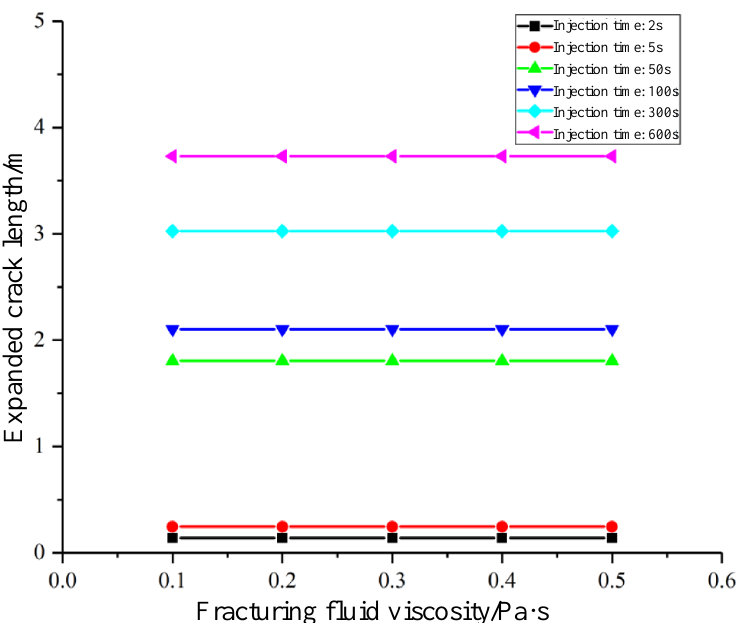
Figure 21. The e ff ect of fracturing fluid viscosity on the crack Figure 21. The effect of fracturing fluid viscosity on the crack propagation.